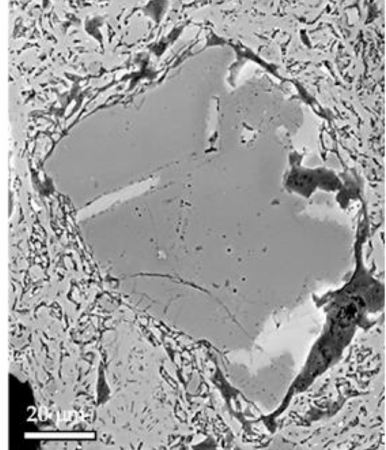
Figure 5. Fracture surface with quartz grain and circumferential crack around it. Abraded, not etched sample (adopted from